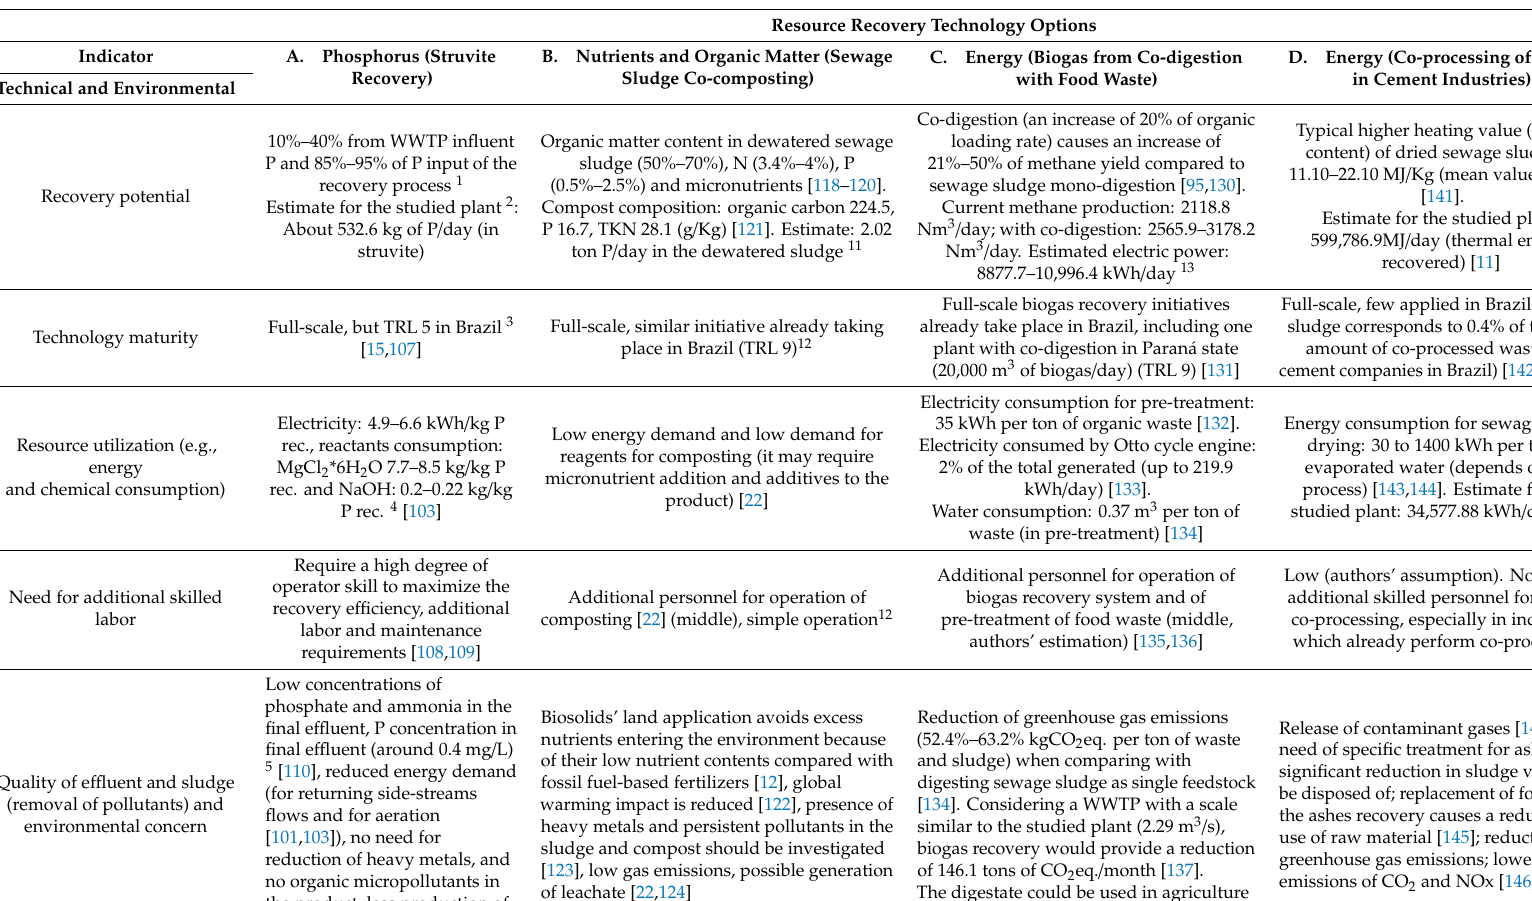
Table 6. Assessment of the recovery technology options against the indicators (step 9 of the framework). Further explanations are in Supplementary Material 3 (SM3).